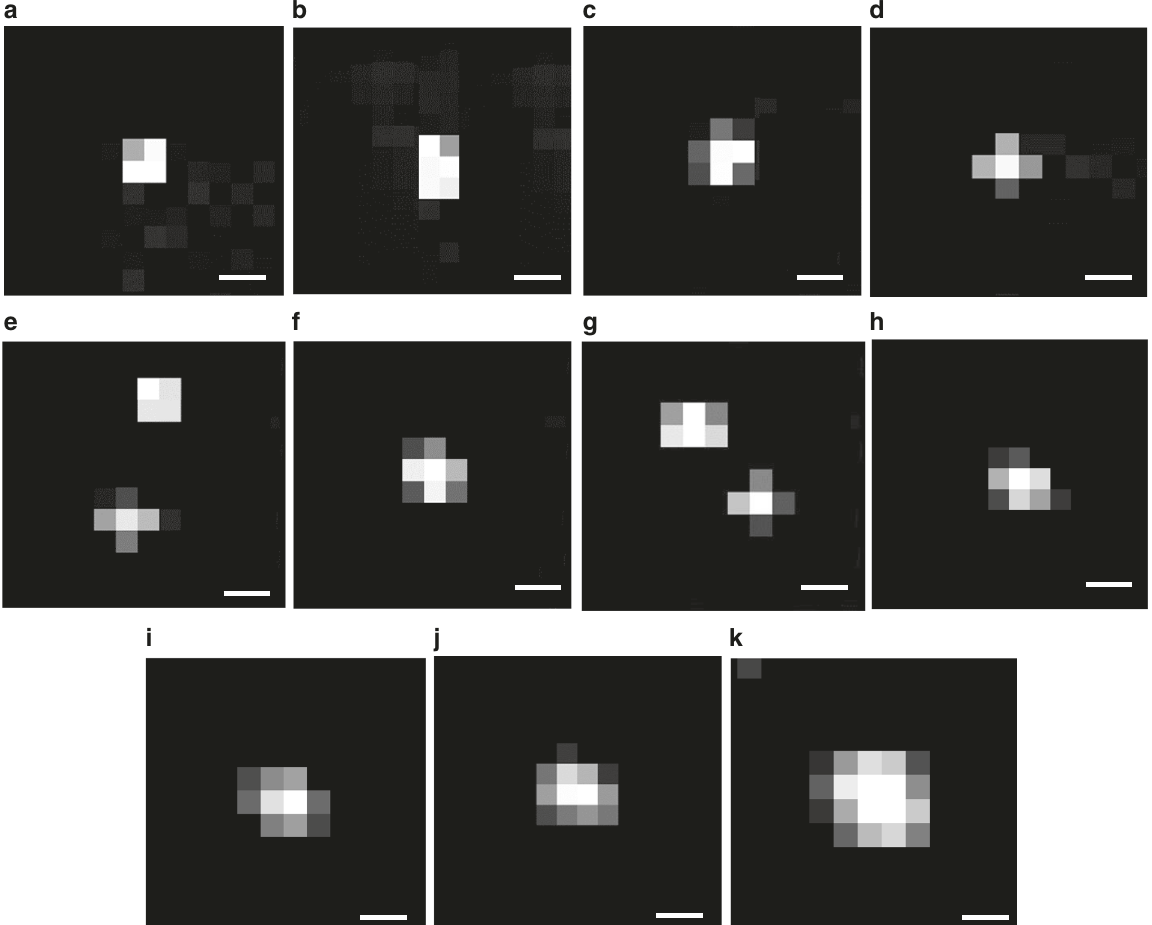
Fig. 4 Detected particle pixel illumination grid via PANORAMA. a – d 25 nm, e 50 nm, f 100 nm, g 200 nm, h , i 300 nm, j 460 nm, and k 750 nm PS bead particle size. Scale bar: 390